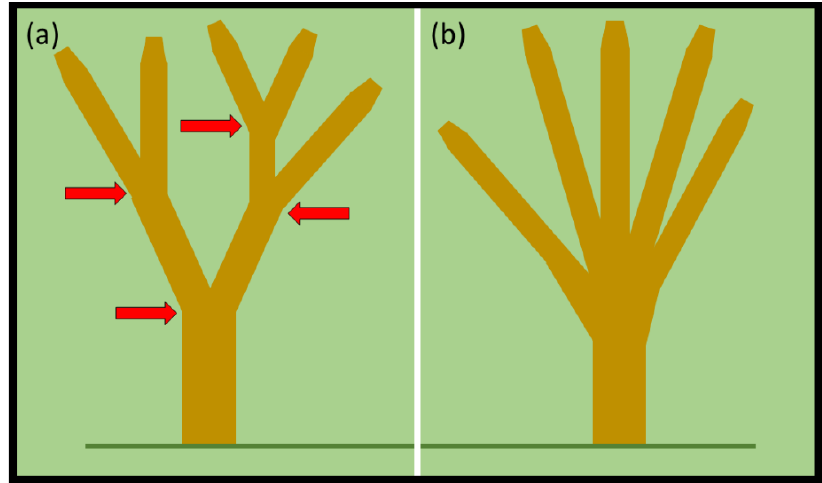
Figure 6. Two approaches for producing branches on a cycad plant. ( a ) Four bifurcations (red arrows) at different strata generate five apices; ( b ) five branches emerge from one stratum.